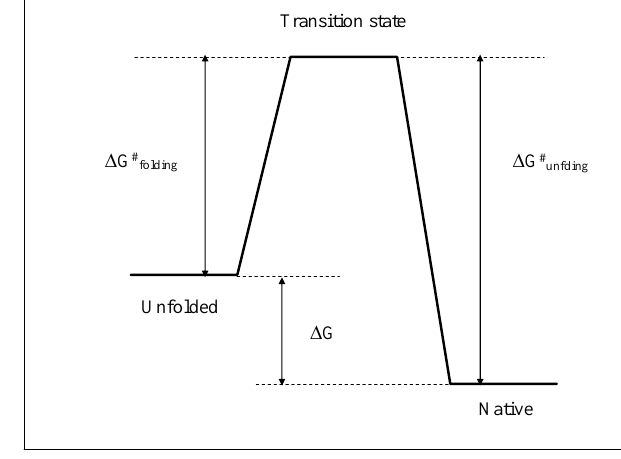
Figure 2. Schematic representation of the energy diagram for the protein folding process, and  G # denote the activation energy between assuming a two-state model.  G # folding unfolding the unfolded and transition states and between the respective native and transition